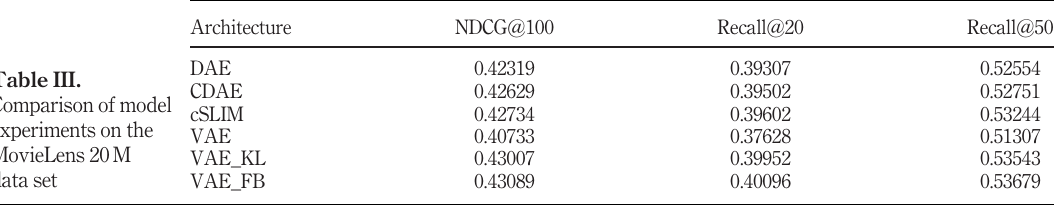
Table III. Comparison of model experiments on the MovieLens